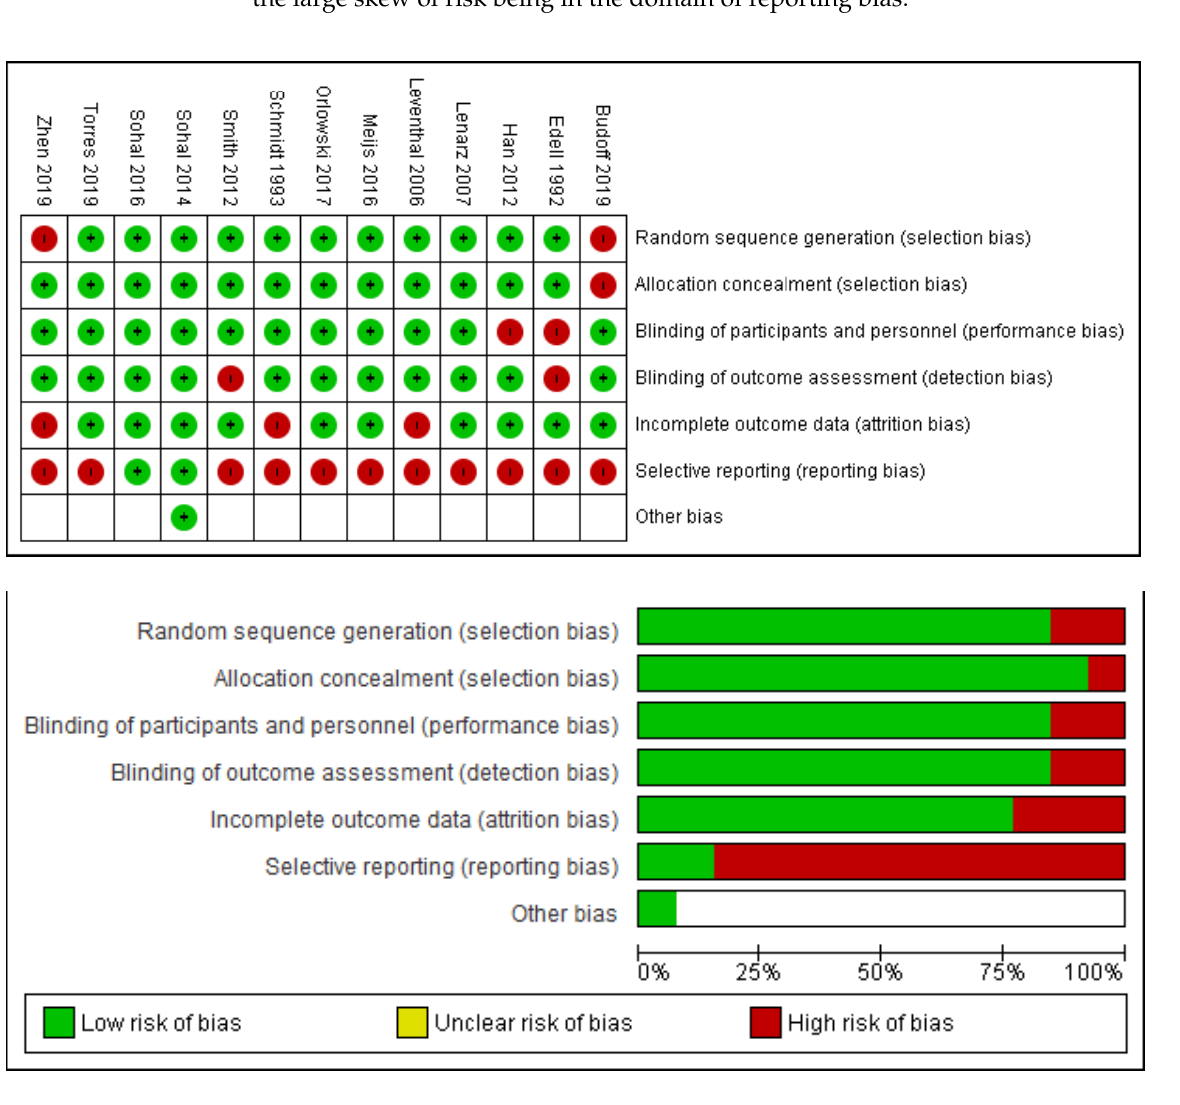
Figure 2. ROBINS summary charts.